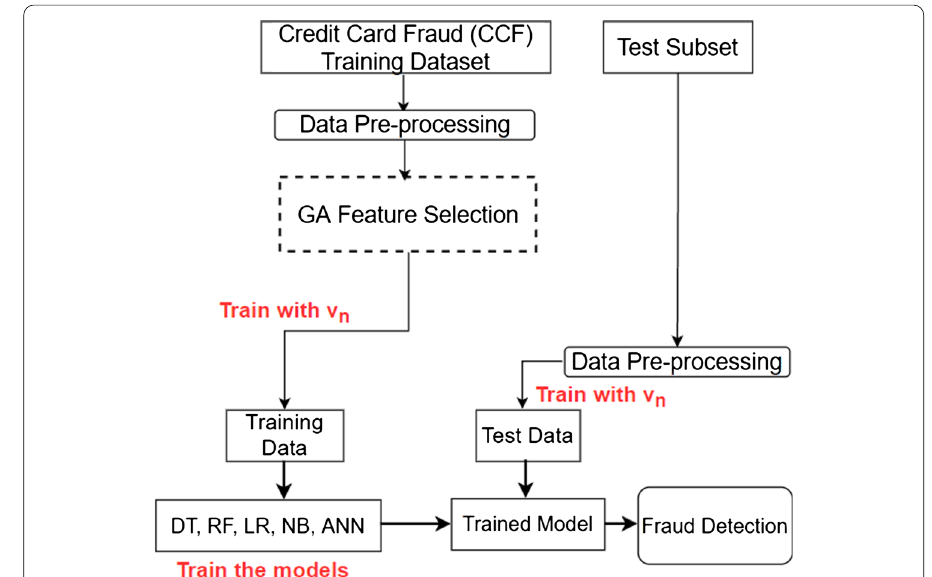
Fig. 3 Architecture of the proposed